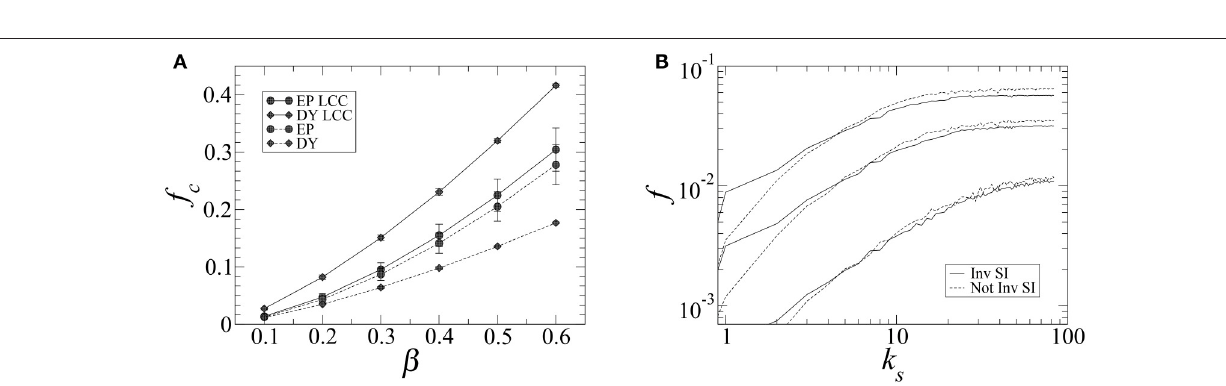
FIGURE 5 | (A) Average fraction f c of informed population by reviews created from users of the LCC of the network vs. the probability of transmission β . The error bars stand for the standard deviation. (B) Average fraction f of informed population by reviews created from users of different k-shells vs. the k-shell number ( k s ) for the case of DY with β ∈ [0.1 , 0.3] . The solid line is according to the assumption that information propagates contrary to the directionality of the link and the dashed line is according to the assumption that information propagates following the directionality of the link (dashed line).